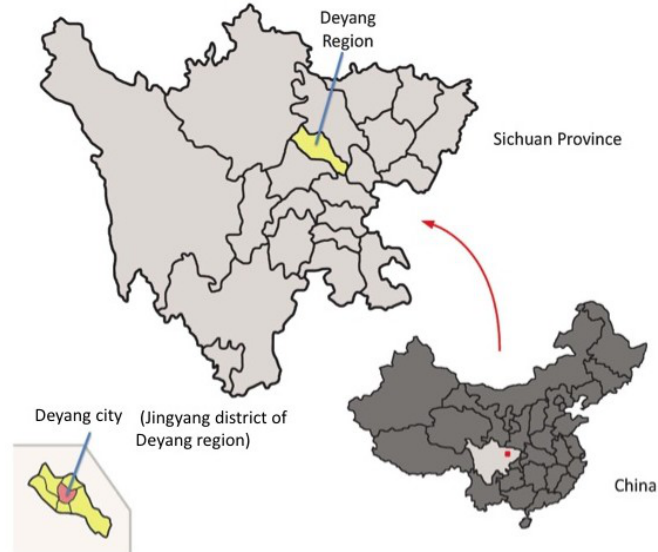
Figure 1. Map of study